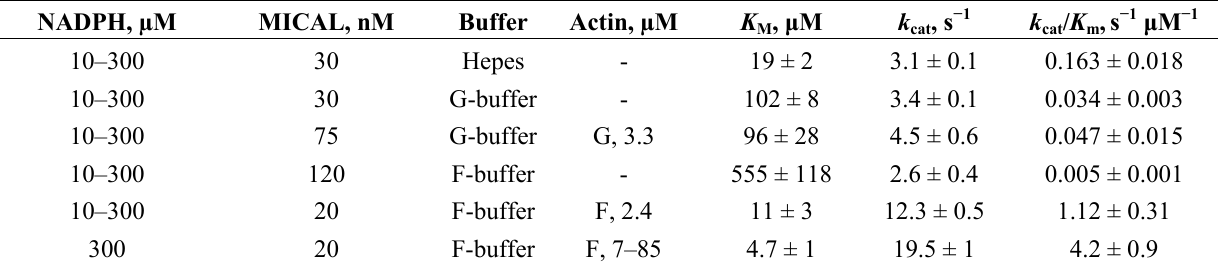
Table 5. Effect of G- and F-actin on the steady-state kinetic parameters of the reaction of human MICAL-MO. The steady-state kinetic parameters of the reaction catalyzed by human MICAL-MO in the absence and presence of G- and F-actin were measured at 25 °C in 20 mM Hepes/KOH buffer, pH 7.0 (Hepes), G-buffer (5 mM Tris/HCl, pH 8.0, 0.2 mM , 0.2 mM ATP, 1 mM DTT) or and F-buffer (9 mM Tris/HCl, pH 8.0, 0.18 CaCl 2